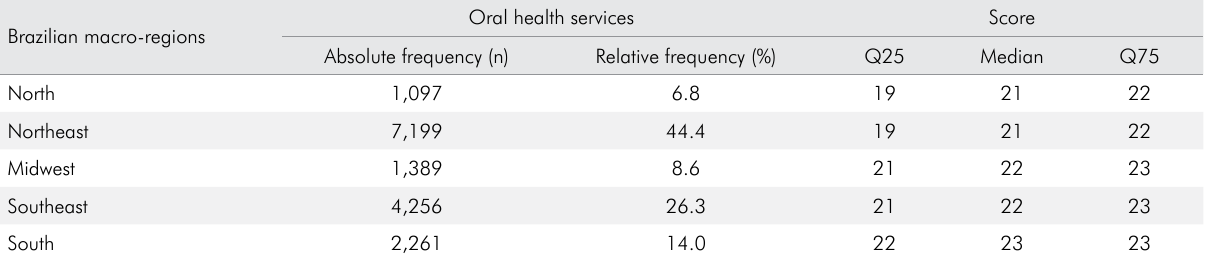
Table 4. Descriptive analysis of oral health services of the OHT evaluated by macro-region and relevant scores for inputs. PMAQ- AB. Brazil, 2013-2014 (n =